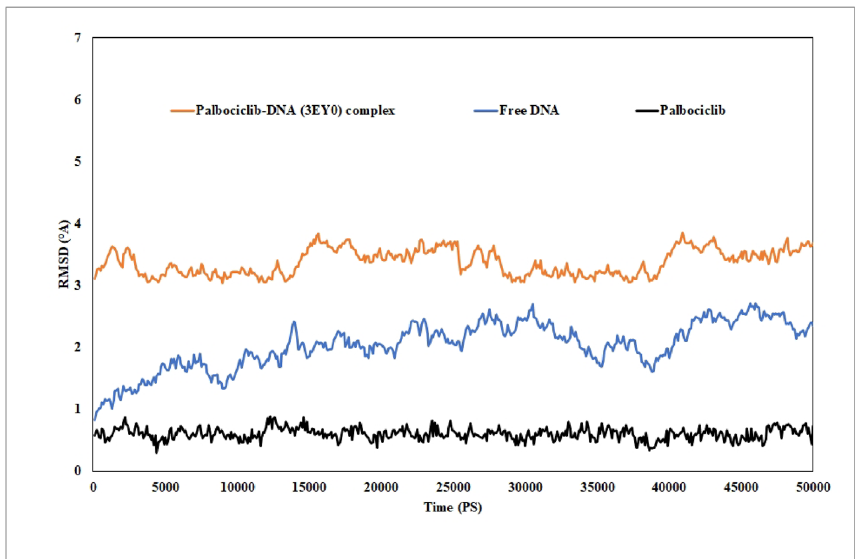
Figure 10. RMSD curves for the heavy atoms of free DNA (3EY0) (blue curve), its complex with PLB (orange curve), and free PLB (black curve) after 50 ns dynamic simulation